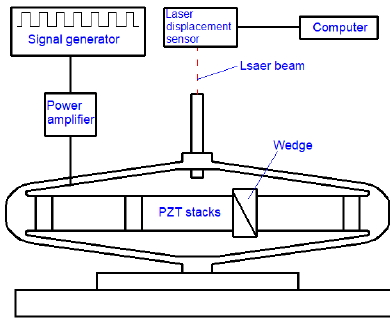
Figure 2. Experimental facilities used to measure the amplifier.